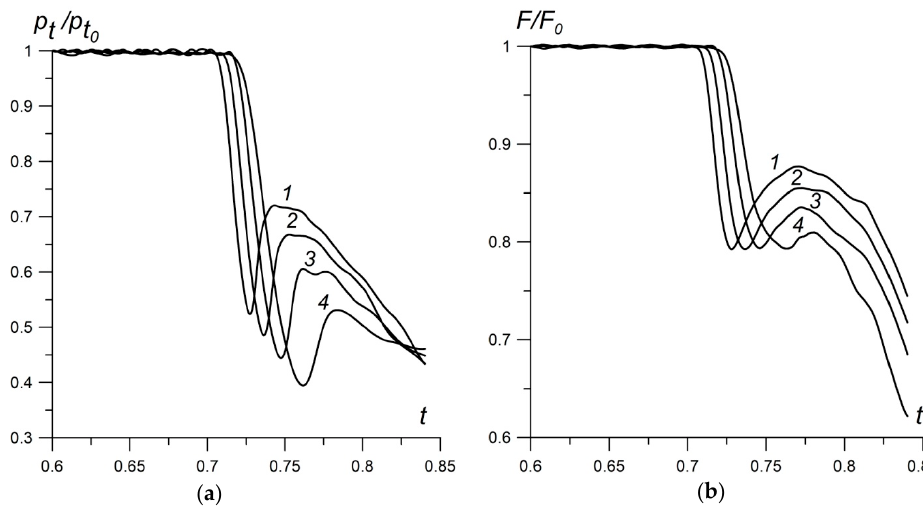
Figure 9. Dynamics of the related stagnation pressure ( a ) and front drag force ( b ) for different γ , M = 4, α ρ = 0.5: curve 1: γ = 1.4, curve 2: γ = 1.3, curve 3: γ = 1.2, and curve 4: γ = 1.1 [5].